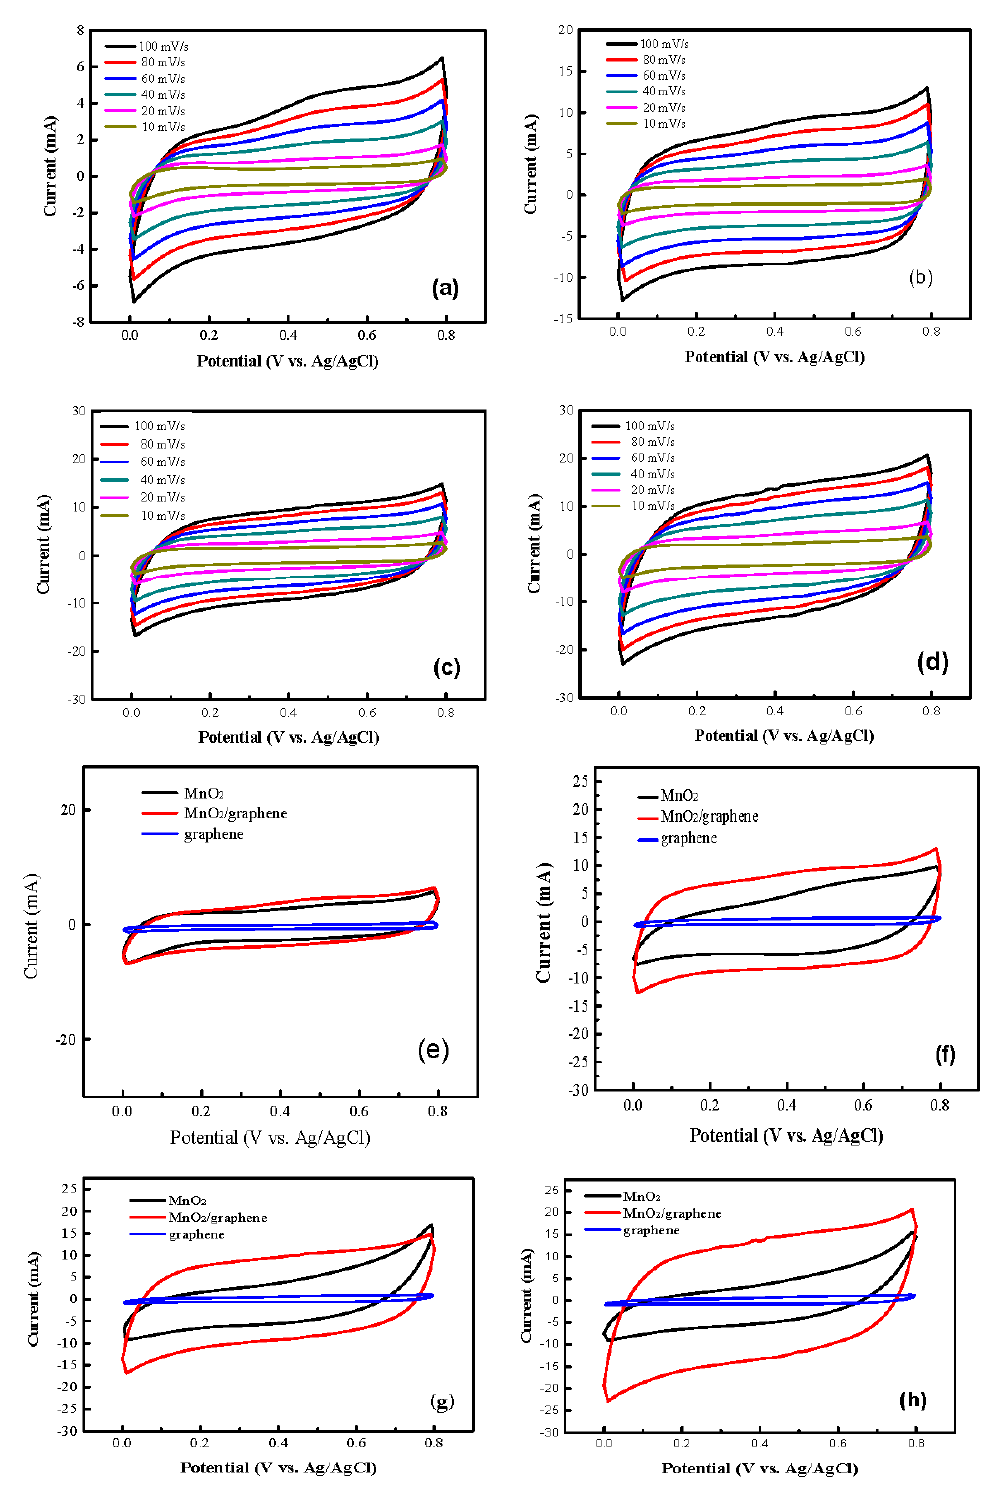
Figure 4. The CV curves of MnO 2 /graphene/Ni electrodes prepared from different current densities using the electrodeposition method: ( a ) 1 mA cm − 2 , ( b ) 5 mA cm − 2 , ( c )10 mA cm − 2 , and ( d ) 15 mA cm − 2 . The CV curves of graphene/Ni, MnO 2 /Ni, and MnO 2 /graphene/Ni electrodes: ( e ) 1 mA cm − 2 , ( f ) 5 mA cm − 2 , ( g )10 mA cm − 2 , and ( h ) 15 mA cm − 2 . Table 1. The specific capacitance of MnO 2 /graphene/Ni foam at different scanning rates under dif- ferent current densities.